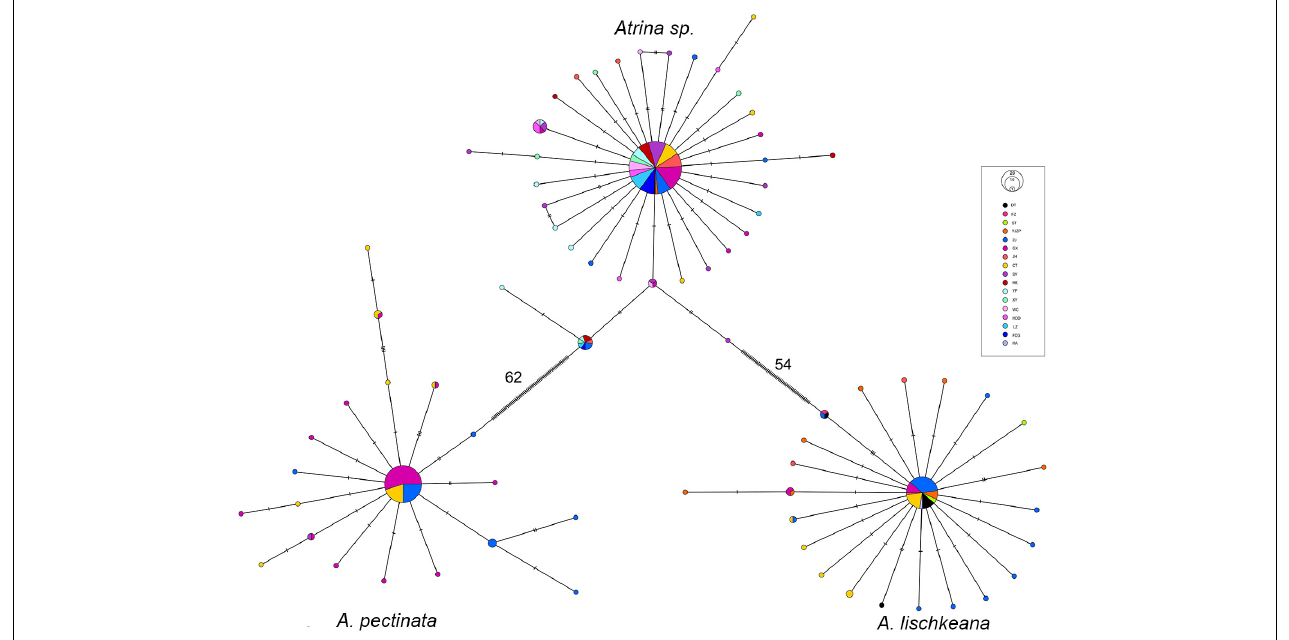
FIGURE 8 | Minimum spanning tree showing genetic relationships among the mt COI haplotypes of A. lischkeana , A. pectinata, and Atrina sp. . The circles represent the haplotypes, and their sizes are proportional to their respective frequencies. The population origins of the haplotypes are indicated by patterns. Tick marks represent the deduced numbers of nucleotide substitutions along each